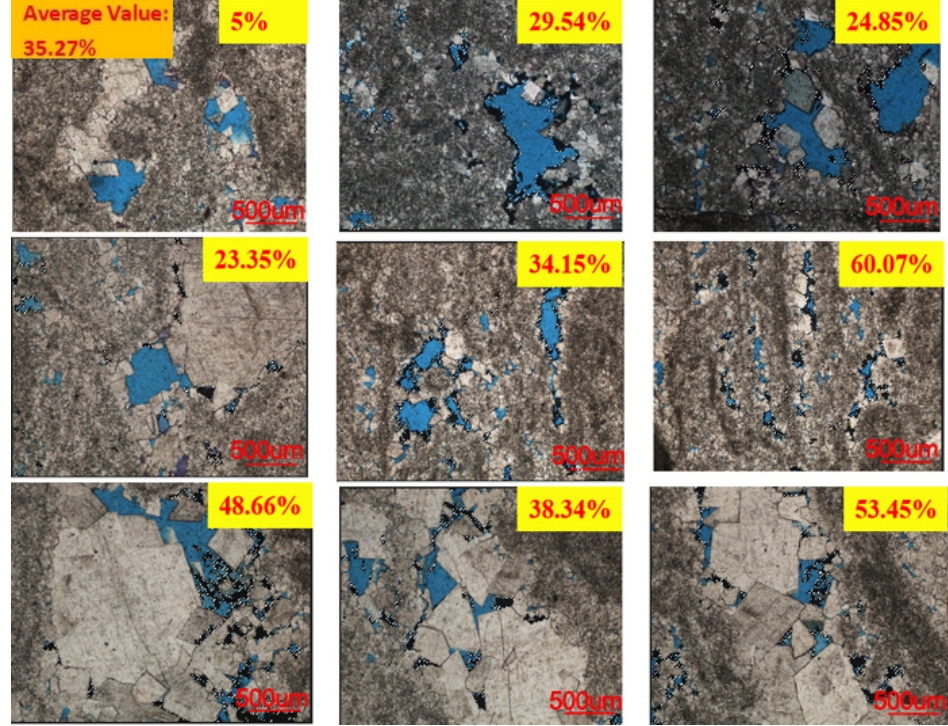
Figure 5. Bitumen content in pores identified using the PSQ method at a depth of 1885.4 m in Well Shutan 1.